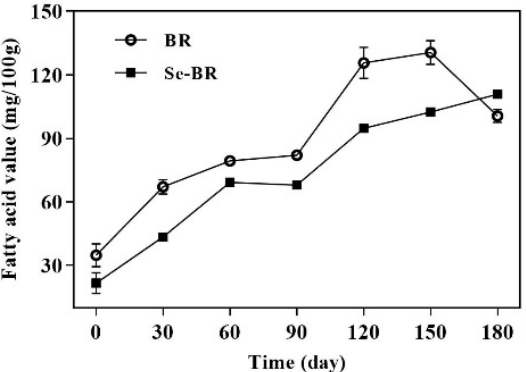
Figure 2. Fatty acid value of BR and Se-BR. Each data point is expressed as the mean and standard error of three replicates.